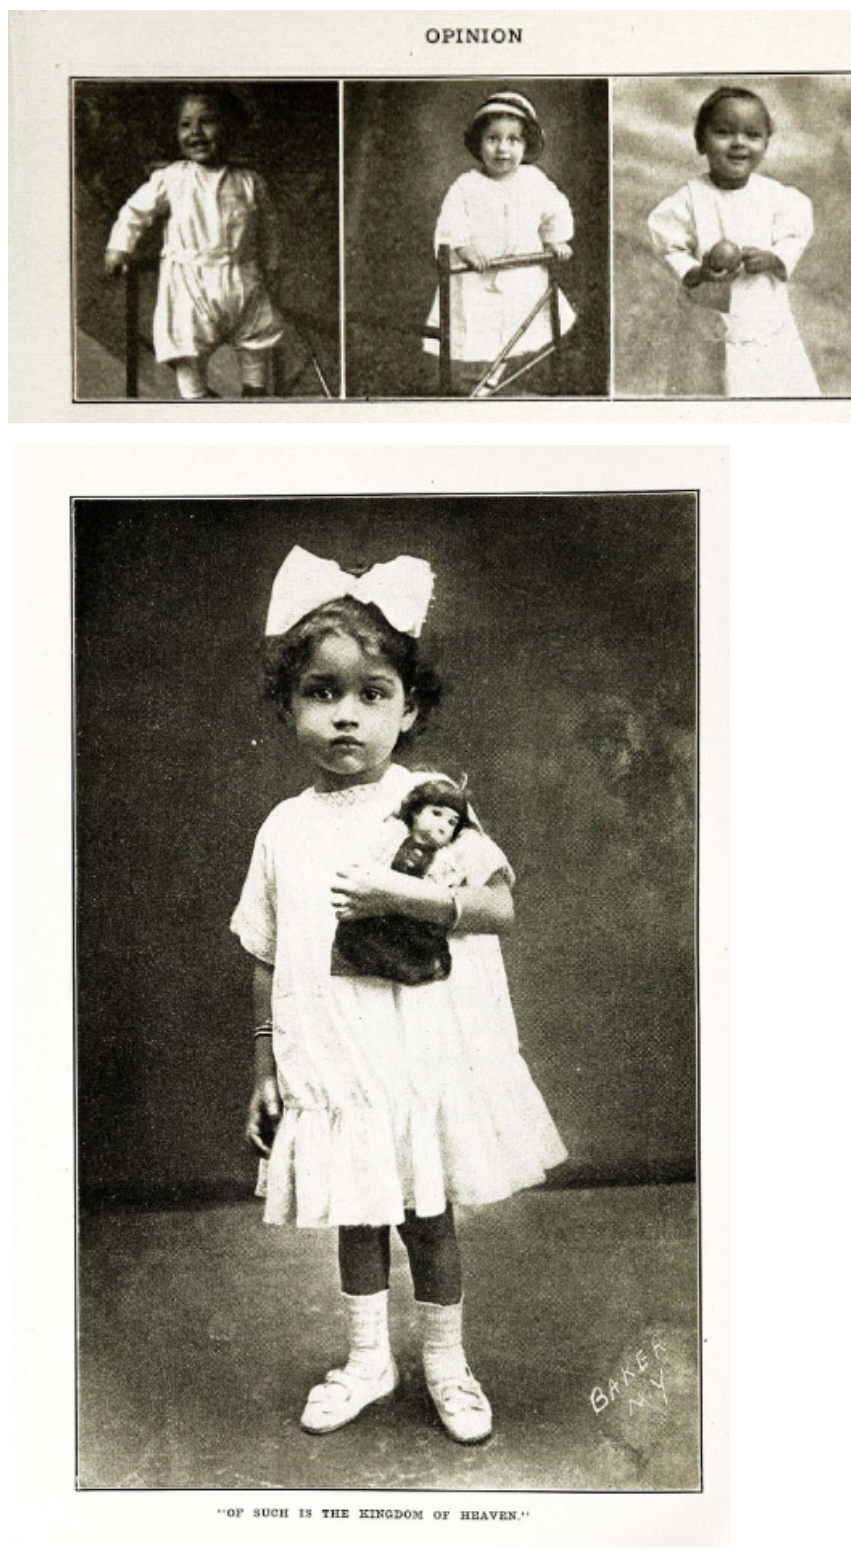
Figure 4. In many images of children in The Crisis , their hands serve as a focal point. Children often grasp objects or hold their hands out in front of them, as in these images from the 1913 Children’s Number. ( The Crisis 1913, 6.6, pp. 277–78), The Modernist Journals Project, https://modjourn.org/is- sue/bdr517569/, (accessed on 8 December 2019). Furthermore, Du Bois aligns the imagery of the child with the moral project of pre- Harlem Renaissance Black poetry that appeared in The Crisis by poets such as Johnson, William Stanley Braithwaite, and James D. Corrothers. Elizabeth Renker (2018) has coined the term “romantic idealism” to define the philosophical underpinning of this type of po- etry, which seeks “a form of transcendent truth that derived its meaning from beyond the world of material circumstance” (p. 5). While not strictly the philosophy of Black poetry in America, there are clear affinities between romantic idealism and the project of racial uplift art, namely the belief in the power of art to enrich and better both the individual